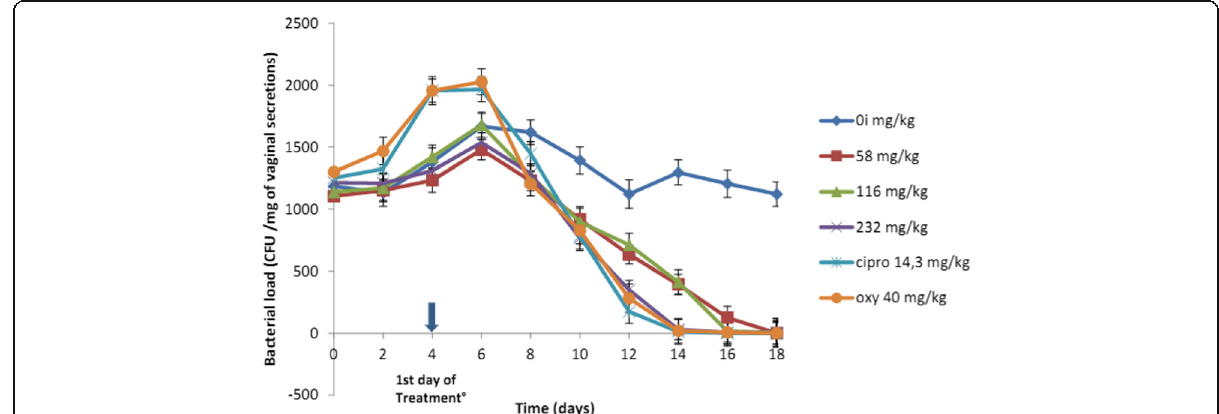
Fig. 3 Evolution of the bacterial load as a function of time